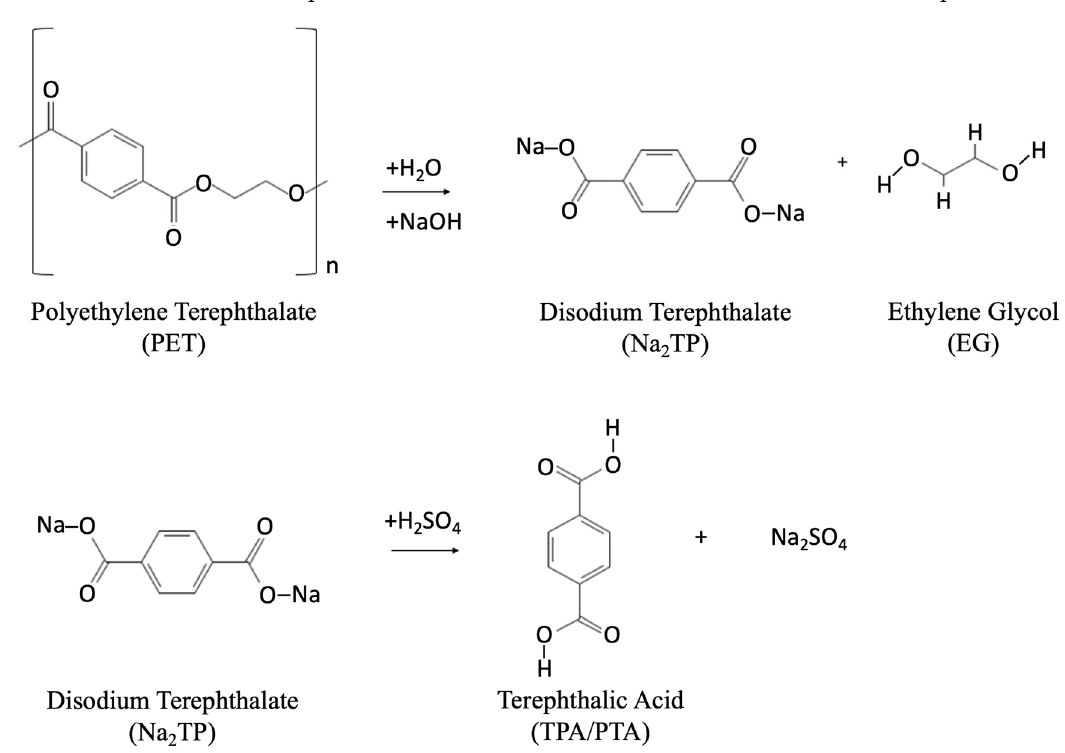
Figure 7. Alkaline hydrolysis chemical reaction to produce